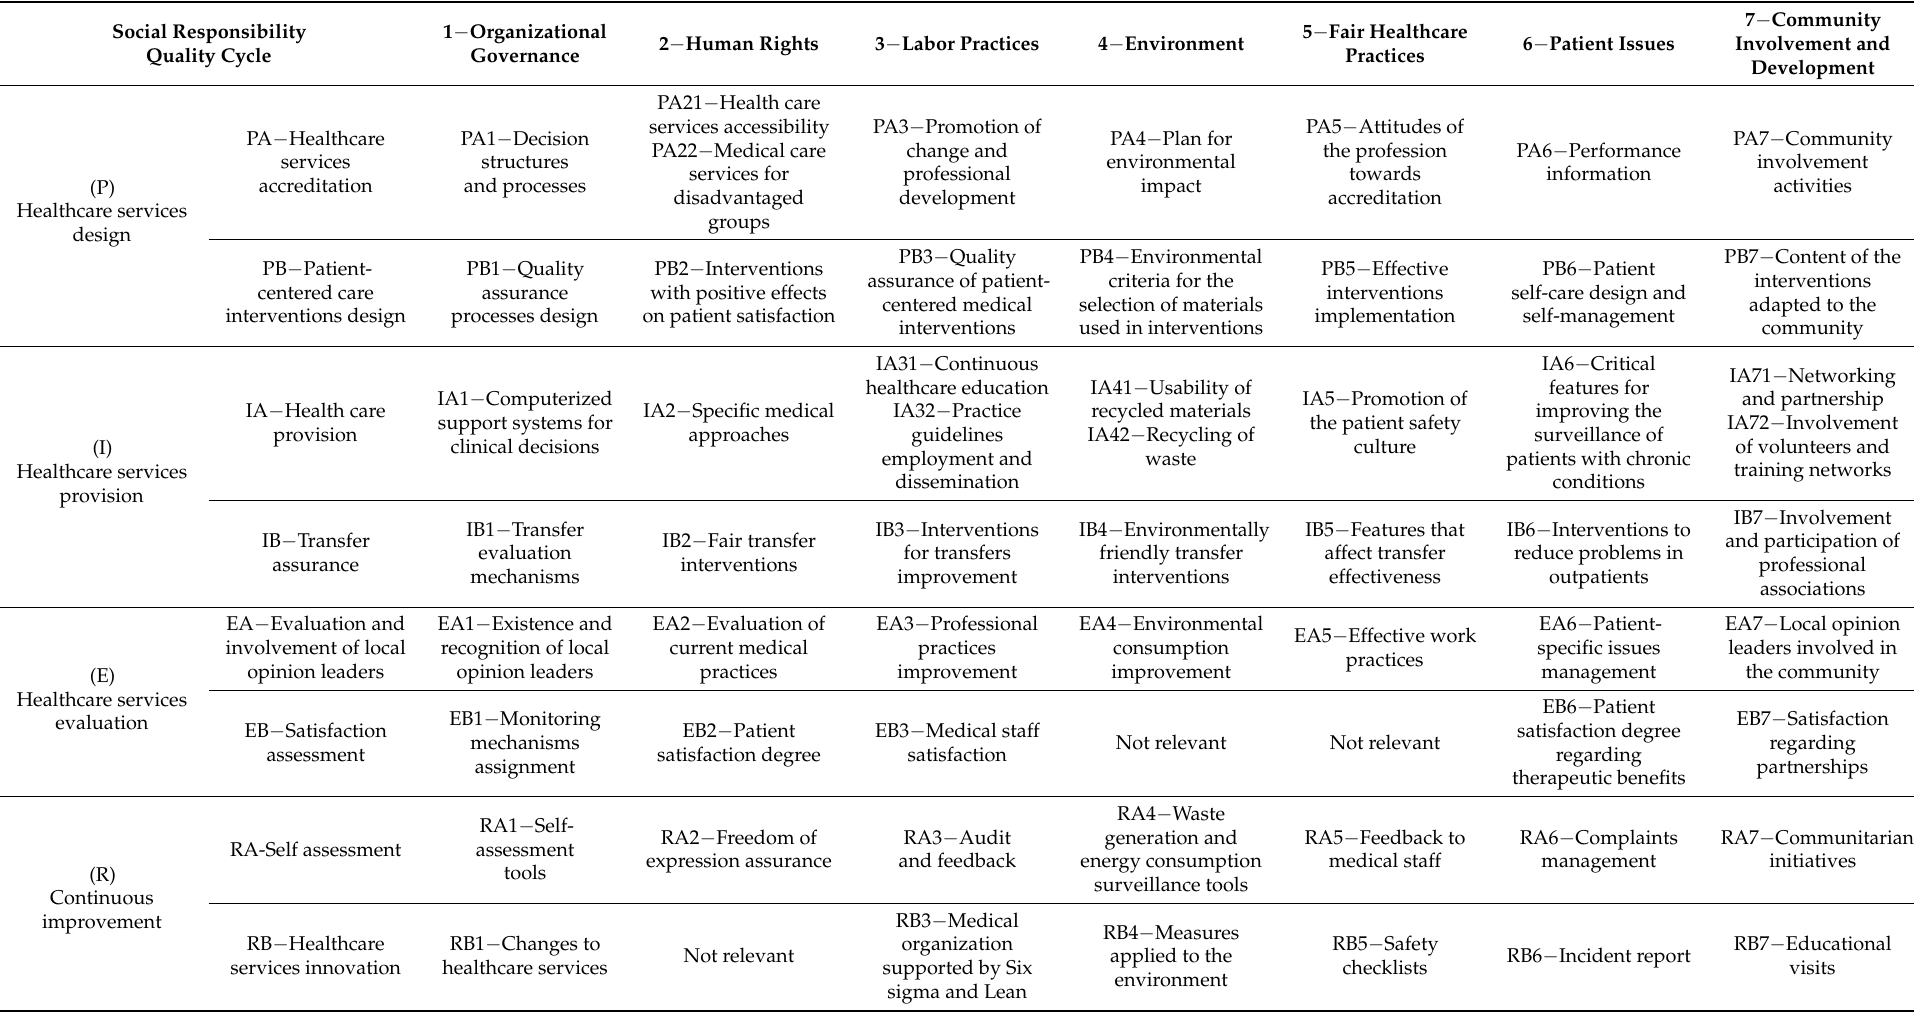
Table 1. The H-S framework indicator